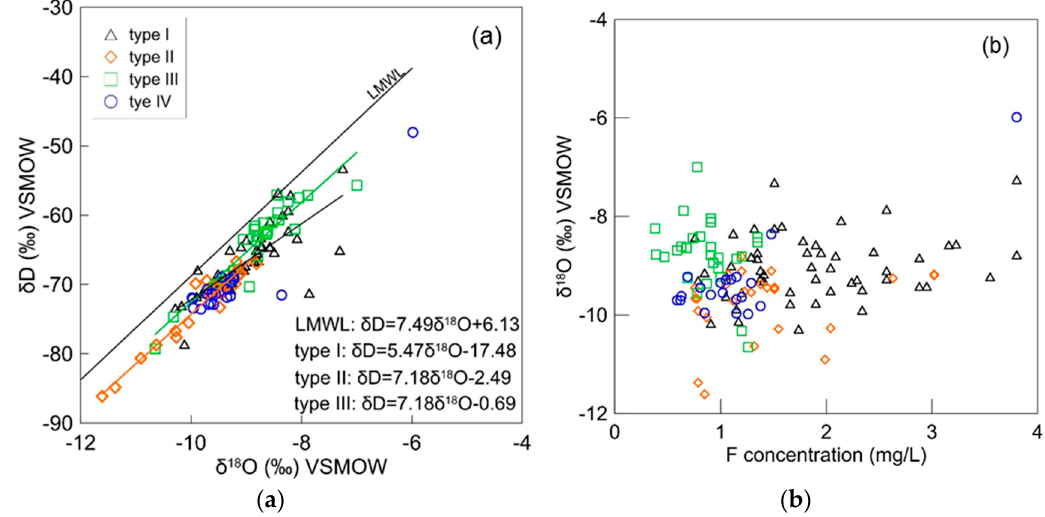
Figure 9. δ 18 O value plotted against ( a ) δ D value and ( b ) F − concentration for area groundwater